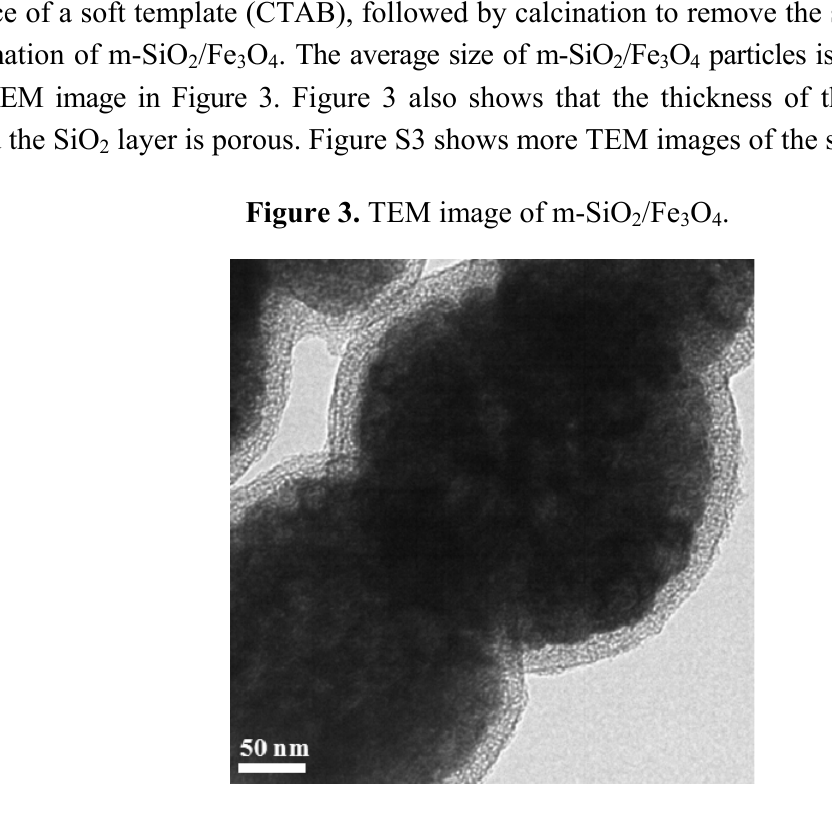
Figure 3. TEM image of m-SiO